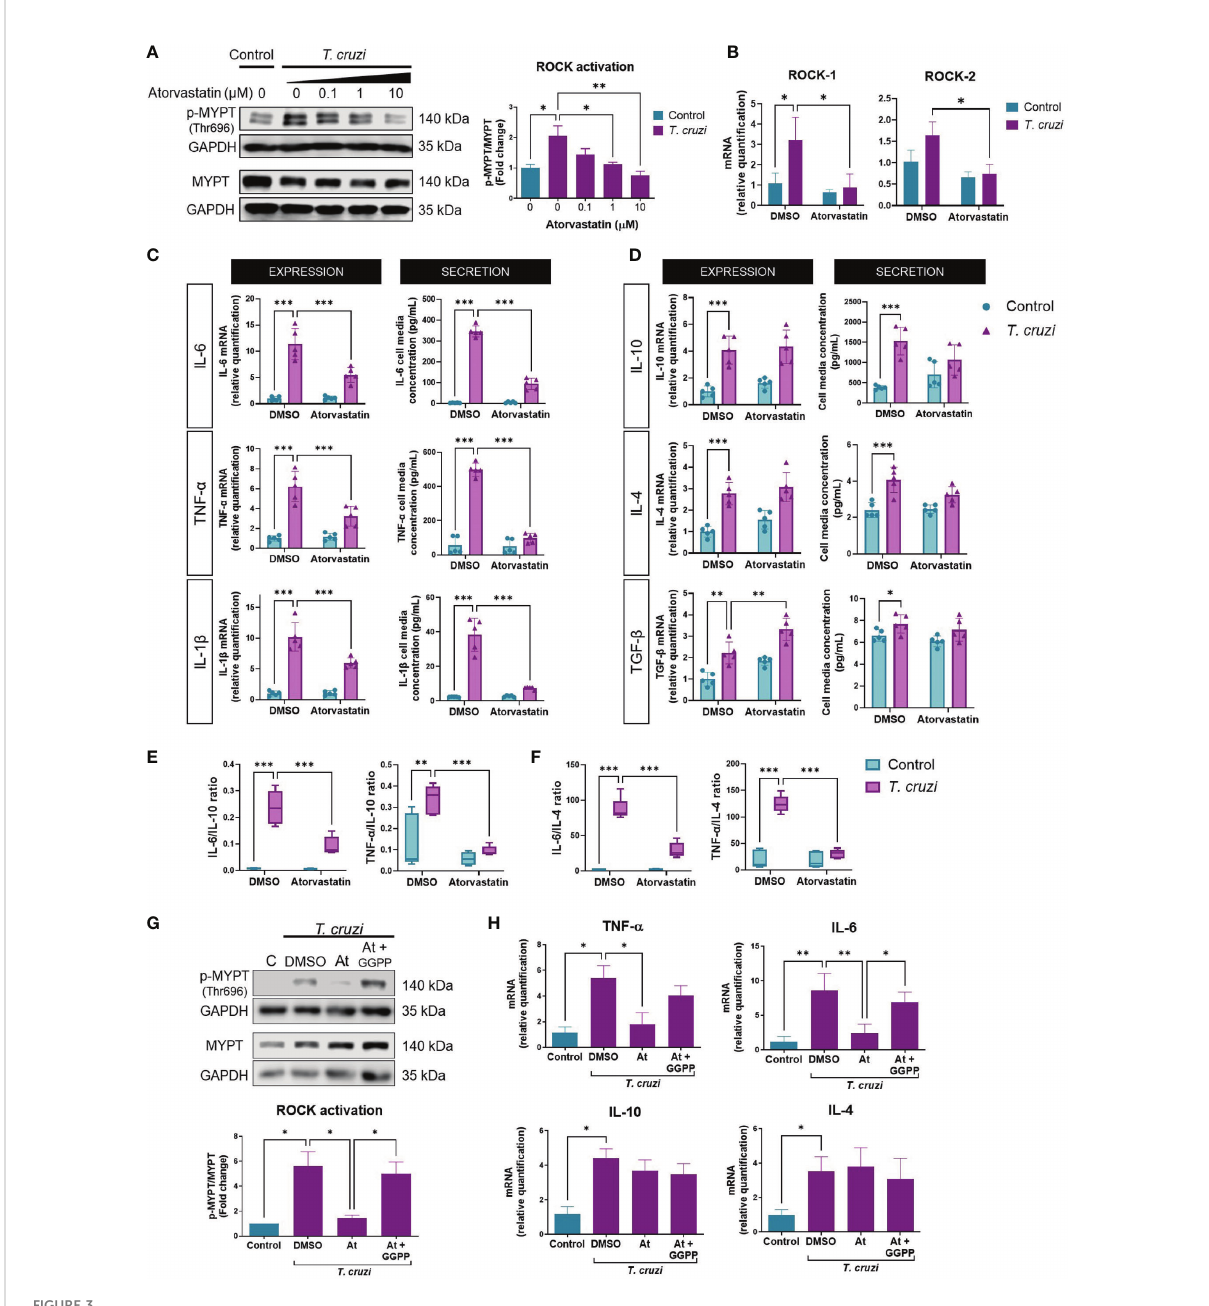
FIGURE 3 Atorvastatin prevents T. cruzi -induced ROCK activation and cytokine pro fi le in macrophages through GGPP depletion. PMA-induced U937 cells were incubated with atorvastatin at increasing concentrations or DMSO (vehicle) for 24 h, and subsequently incubated with or without T. cruzi for 30 min. (A) Left, representative western blot and right, ROCK activation relative to control, measured as phosphorylated (p-MYPT1) to total MYPT1 ratio. (B) 24 h post-infection, total RNA was extracted to determine ROCK1 and ROCK2 mRNA levels relative to DMSO control. (C) PMA-induced U937 cells were incubated with atorvastatin or DMSO for 24 h and then incubated with or without T. cruzi for 30 min. 6 h post-infection, total RNA was extracted for RT-qPCR analysis, and 24 h post-infection, cell media were collected for Multiplex analysis of M1 and (D) M2 markers. (E) Secreted IL-6 and TNF- a to IL-10 ratios. (F) Secreted IL-6 and TNF- a to IL-4 ratios. (G) PMA-induced U937 cells were incubated with atorvastatin or atorvastatin plus 10 µM geranylgeranyl pyrophosphate (GGPP) or DMSO for 24 h, then incubated with or without T. cruzi for 30 min. ROCK activation was determined as the ratio of phosphorylated (p-MYPT1) to total MYPT-1 (MYPT1), relative to control, measured by western blot. (H) 6 h post-infection, total RNA was extracted for RT-qPCR analysis. Data are expressed as mean ± SD of 3 (A, B, G, H) and 5 (C – F) independent experiments. *p<0.05, **p<0.01, ***p<0.001, analyzed with two-way ANOVA and Tukey